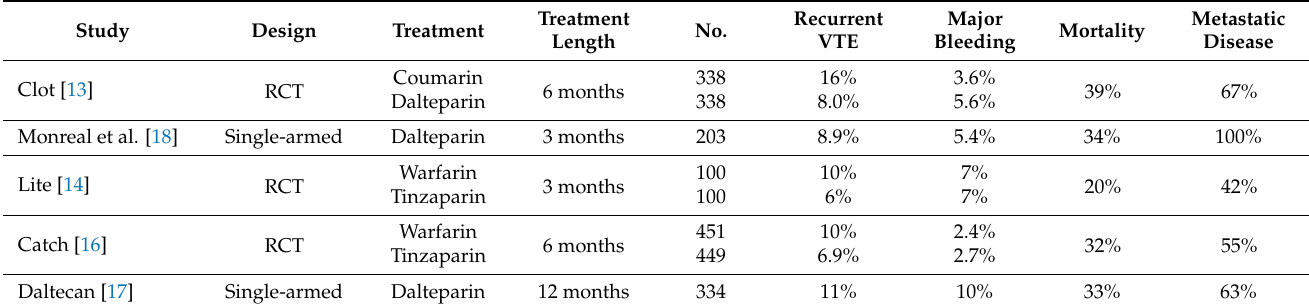
Table 2. Studies on cancer-associated VTE treated with vitamin K antagonists or LMWH.